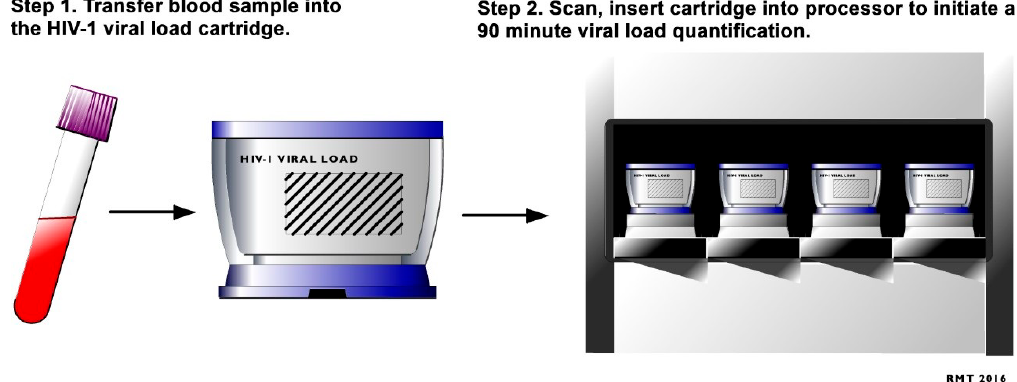
Figure 2. HIV-1 Viral Load quantitative point-of-care testing process adapted from Cepheid Solutions